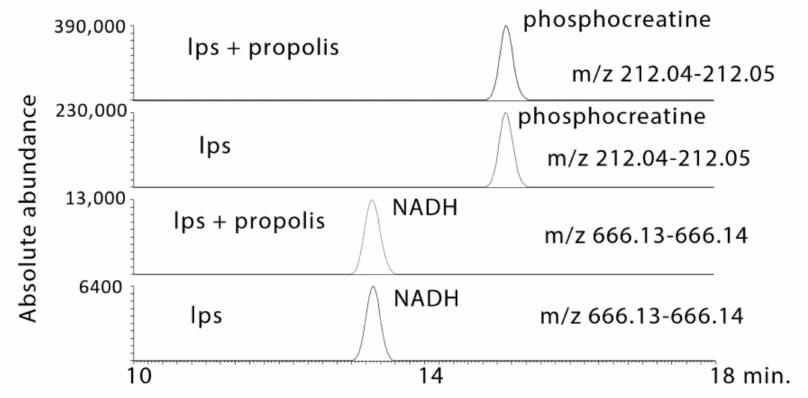
Figure 8. Extracted ion traces showing increased in phosphocreatine and NADH in LPS-stimulated macrophages treated with